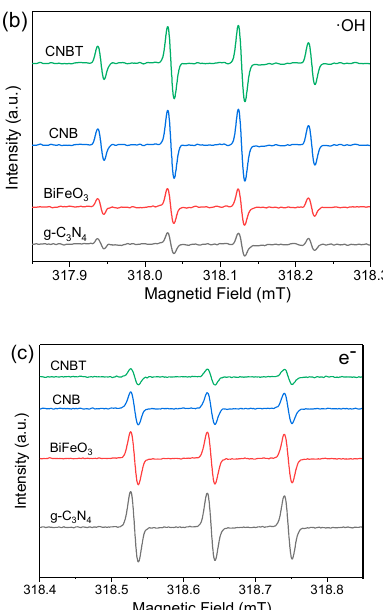
Figure 4. ( a ) ESR spectra of radical adducts trapped by · O 2 − and · OH for CNBT in the dark and under visible light irradiation. ( b , c ) ESR spectra of g-C 3 N 4 , BiFeO 3 , CNB, and CNBT by · OH ( b ) and e − ( c ) exposed to visible light for 10 min.